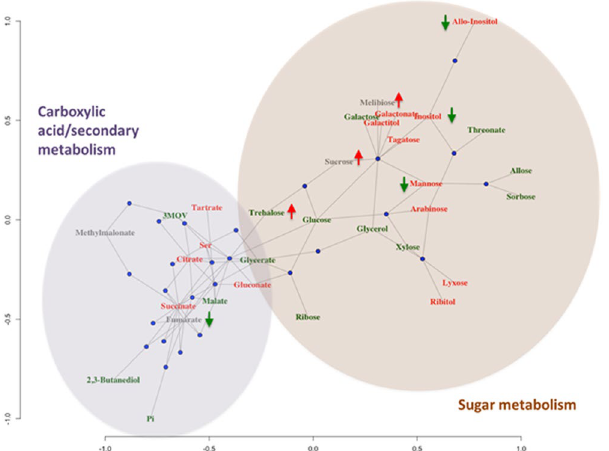
Figure 4. KEGG pathway analysis of the analyzed metabolites, using A. thaliana pathway dataset (Table S3). Two functional groups can be observed at the bipartite plot (carboxyclic acid/secondary metabolism and sugar metabolism).